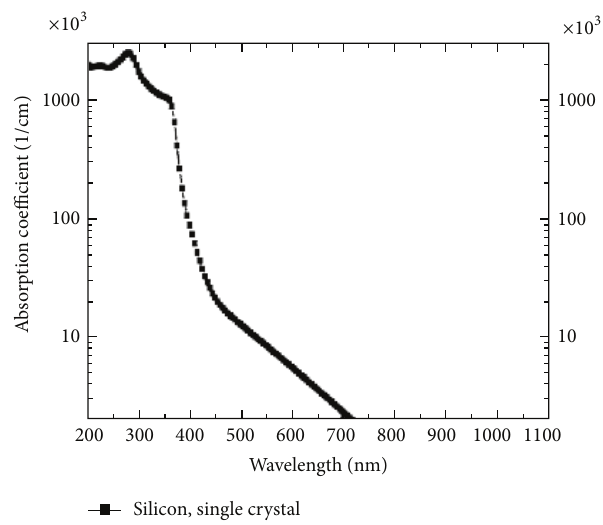
Figure 1: Absorption coefficient of silicon depending on the wavelength at 25 ∘ C for a 600 𝜇 m thick polished sample